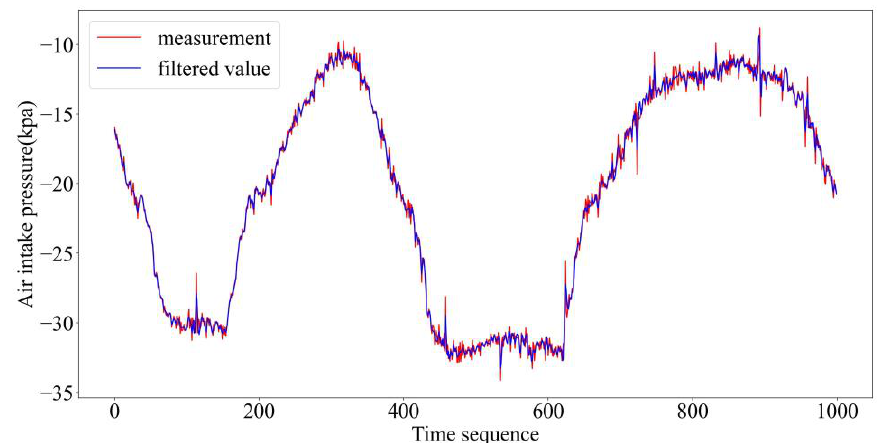
Figure 7. Intake pressure after filtering.